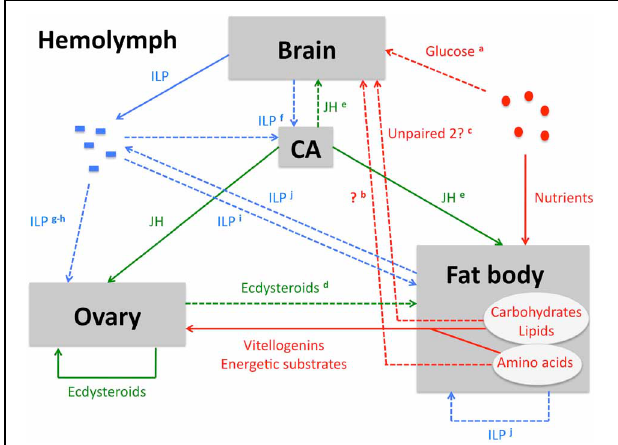
FIGURE 2 | Schematic overview of the key players in ISP-mediated control of female insect reproductive physiology. Solid lines represent a consensus, a process that has been demonstrated in several insect orders. [It needs to be emphasized that the role of ISP in honeybee reproduction strongly deviates from the consensus. Therefore, information from the honeybee is not taken into account in this overview.] Dashed lines represent processes that have only been demonstrated in a limited number of insect species or orders, or that may possibly act more indirectly than suggested on the figure. These lines go accompanied by a remark, indicated by a superscript character. Nutrient-related (signaling) pathways (red arrows): Upon digestion of food in the midgut, nutrients are absorbed by the midgut cells and subsequently released into the hemolymph. They are either directly used by the tissues as a source of metabolic energy or as a substrate in anabolic reactions, or they are stored in fat body cells. The fat body’s nutritional stores may then be mobilized for the production of vitellogenins, energetic substrates and other